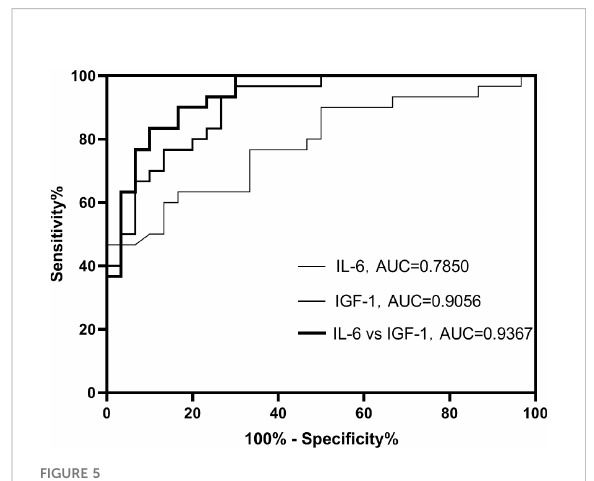
FIGURE 5 ROC curves for the separation and combination of serum IGF-1 and serum